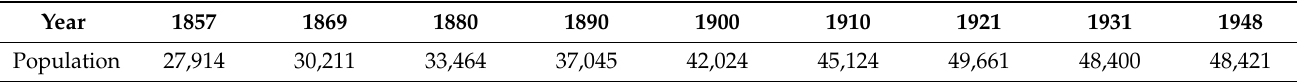
Table 1. Population growth in the northern Dalmatian islands from 1857 to 1948